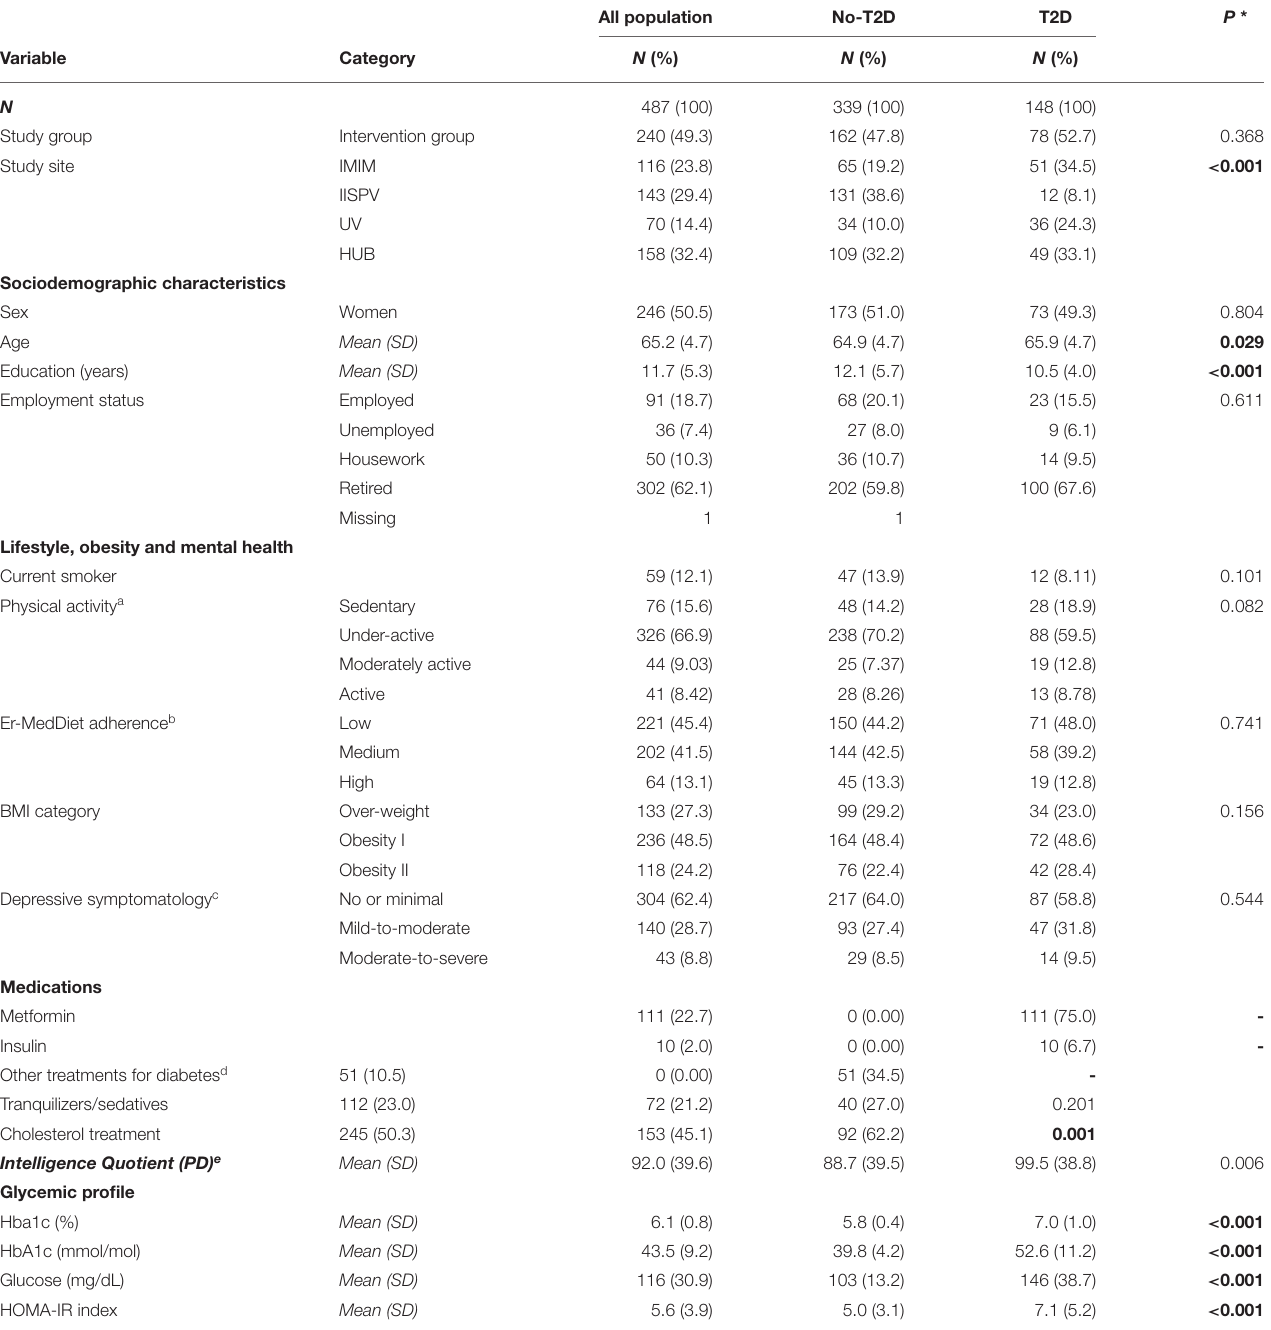
TABLE 1 | Baseline characteristics of study participants stratified by type 2 diabetes (T2D) status and univariate differences. All population No-T2D